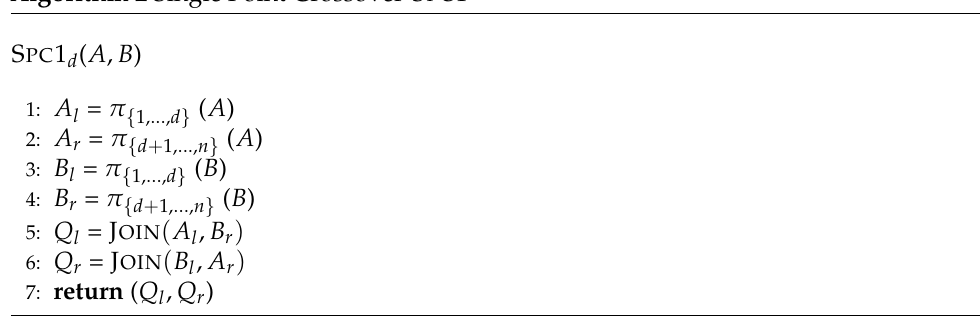
Algorithm 2 Single Point Crossover-S PC